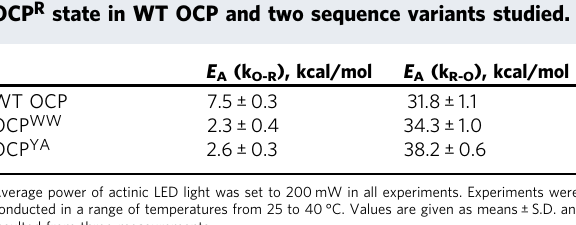
Table 2 Apparent activation energies ( E A ) for the rate of accumulation (k O-R ) and subsequent relaxation (k R-O ) of the OCP R state in WT OCP and two sequence variants studied.